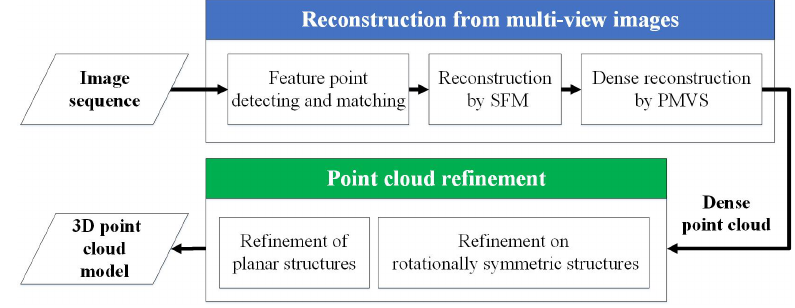
Figure 1. Framework for the reconstruction of space objects. PMVS, patch-based multi-view